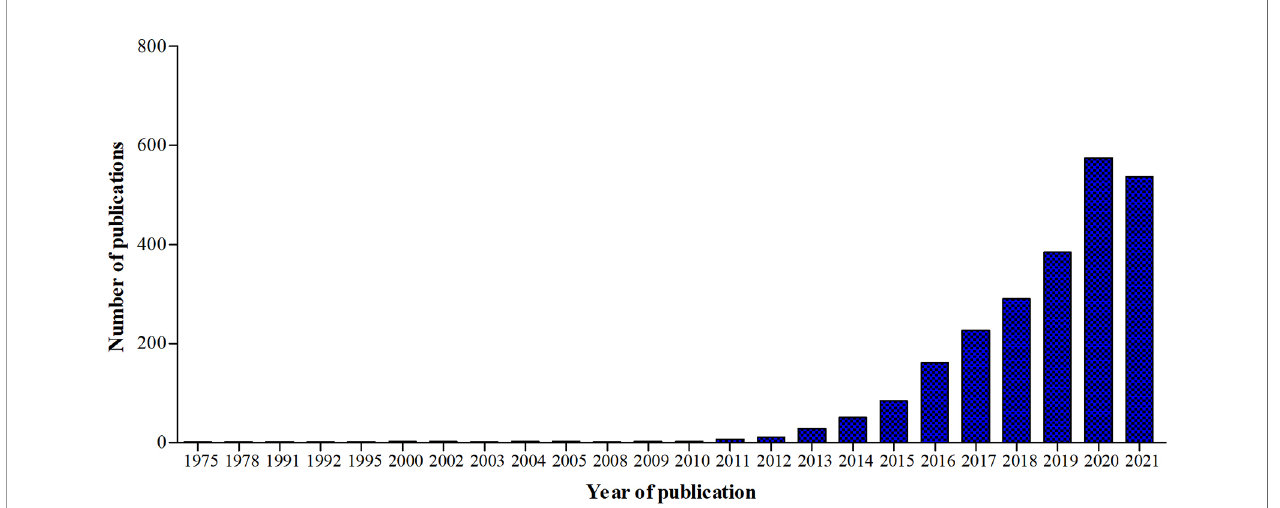
FIGURE 5 | Graphic representation of the number of publications in Pubmed.gov using the keyword ‘ Immunometabolism ’ from 1975 until